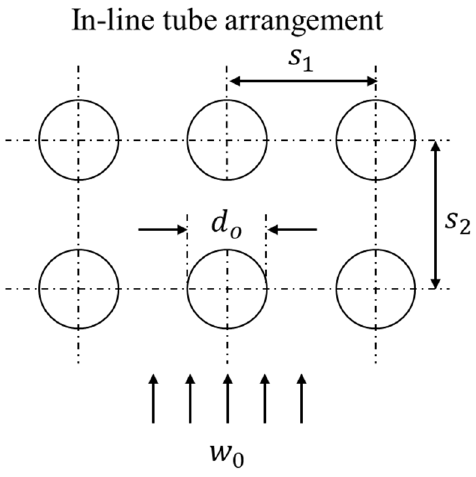
Figure 2. Lateral and longitudinal spacing in in-line tube